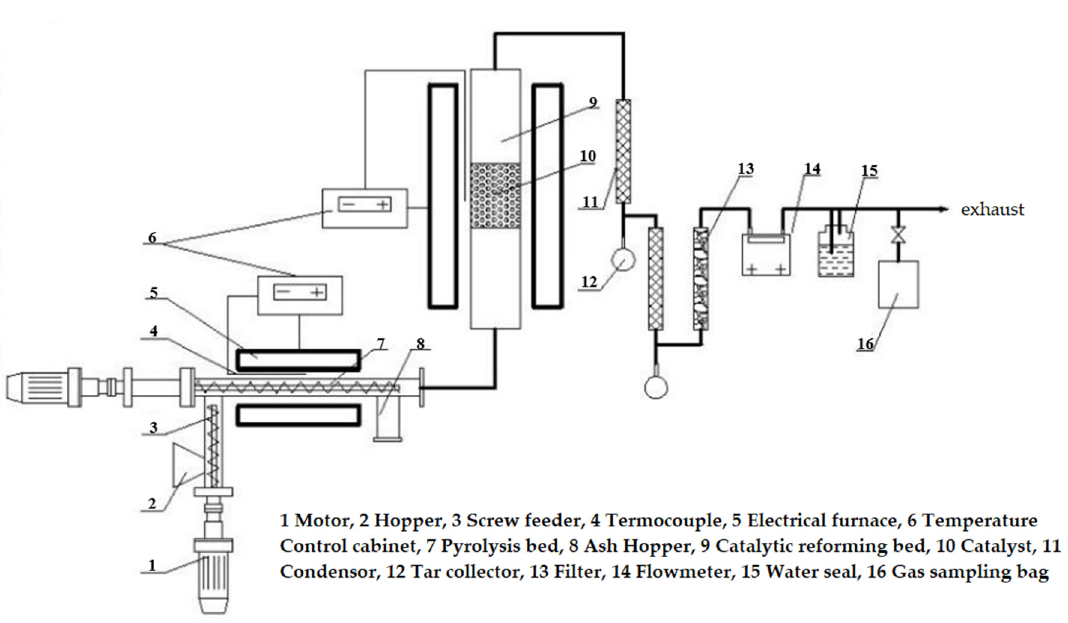
Figure 6. The TEM image of the nanoparticles of the NiO. Table 4. The surface properties of γ -A1 2 O 3 and nano-NiO/ γ -A1 2 O 3.